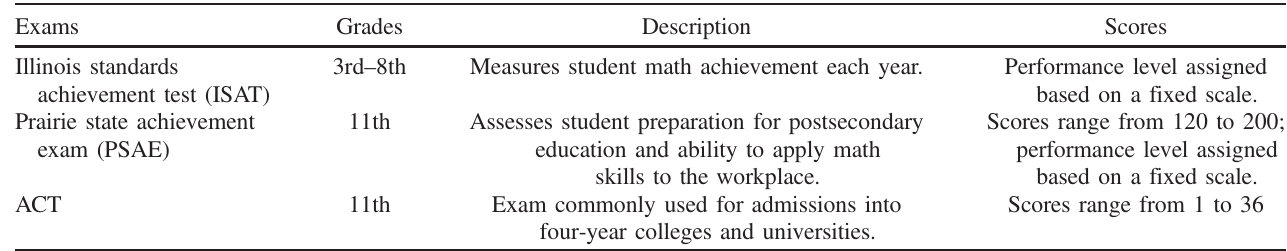
TABLE I. Description of standardized exams from which scores are used for this analysis.